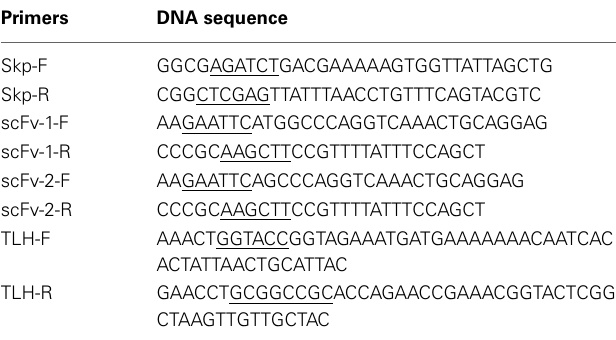
Table 1 | Primers used in the present